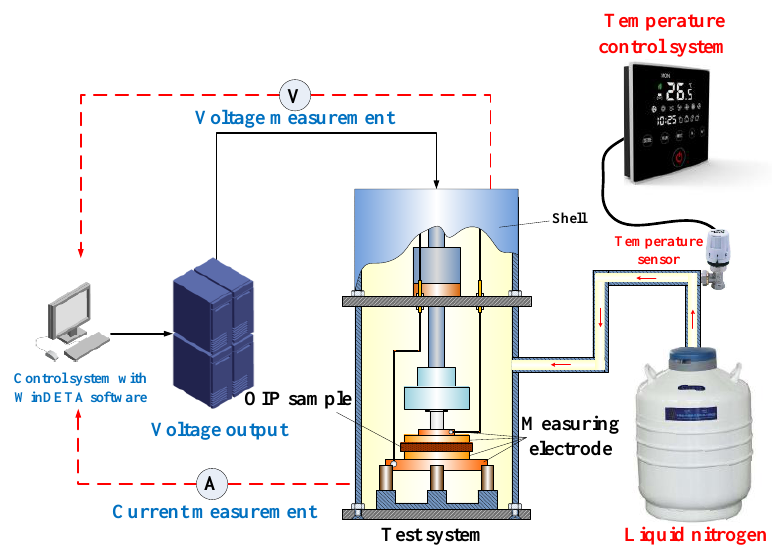
Figure 4. Thermally Stimulated Current (TSC) measurement system.